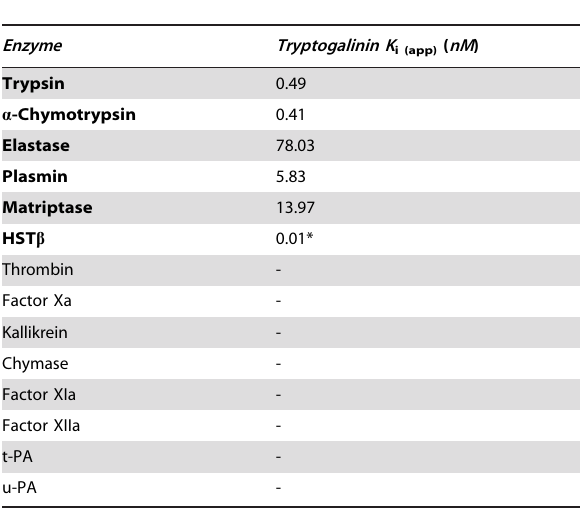
Table 1. Protease inhibition by